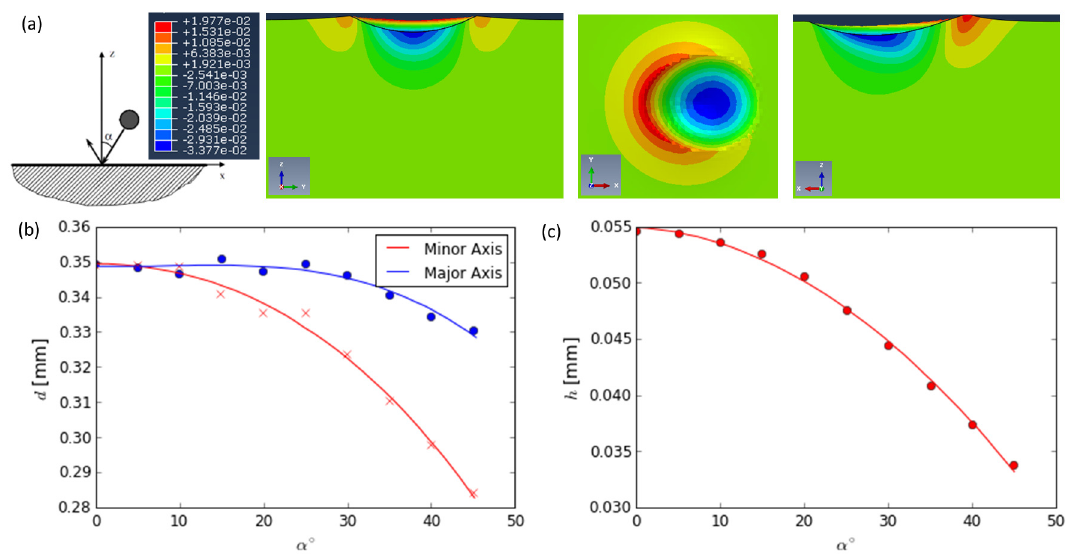
Figure 2. ( a ) Different views of the elliptical indent generated by an oblique impact represented in vertical displacement contours. The prediction of ellipse indent size for oblique impacts (shot diameter = 0.6 mm, shot velocity = 60 mm s − 1 ) obtained from the single impact FEM analysis; ( b ) major and minor axis; ( c ) ellipse max depth.